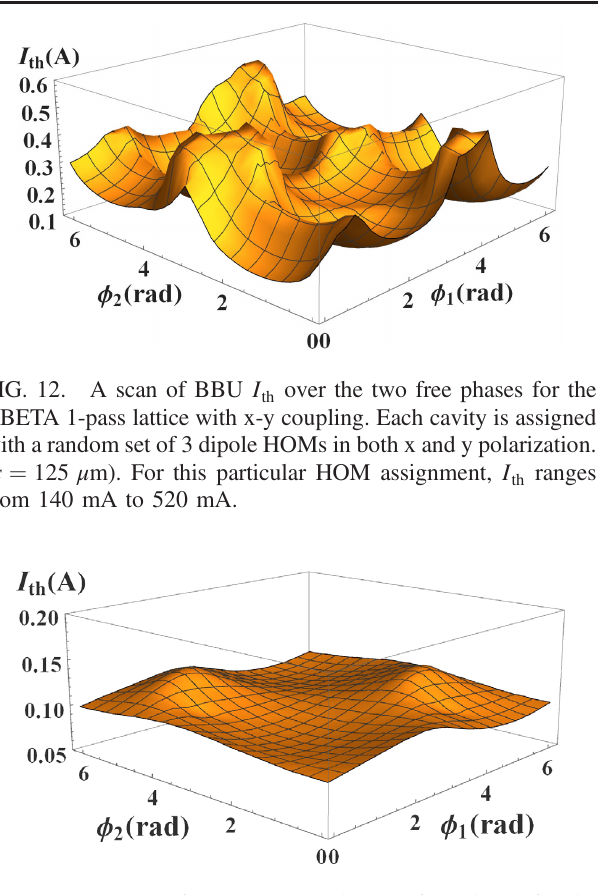
FIG. 13. A scan of BBU I over the two free phases for the th CBETA 4-pass lattice with x-y coupling. Each cavity is assigned with a random set of 3 dipole HOMs in both x and y polarization. ( ϵ ¼ 125 μ m). For this particular HOM assignment, I ranges th from 89 mA to 131